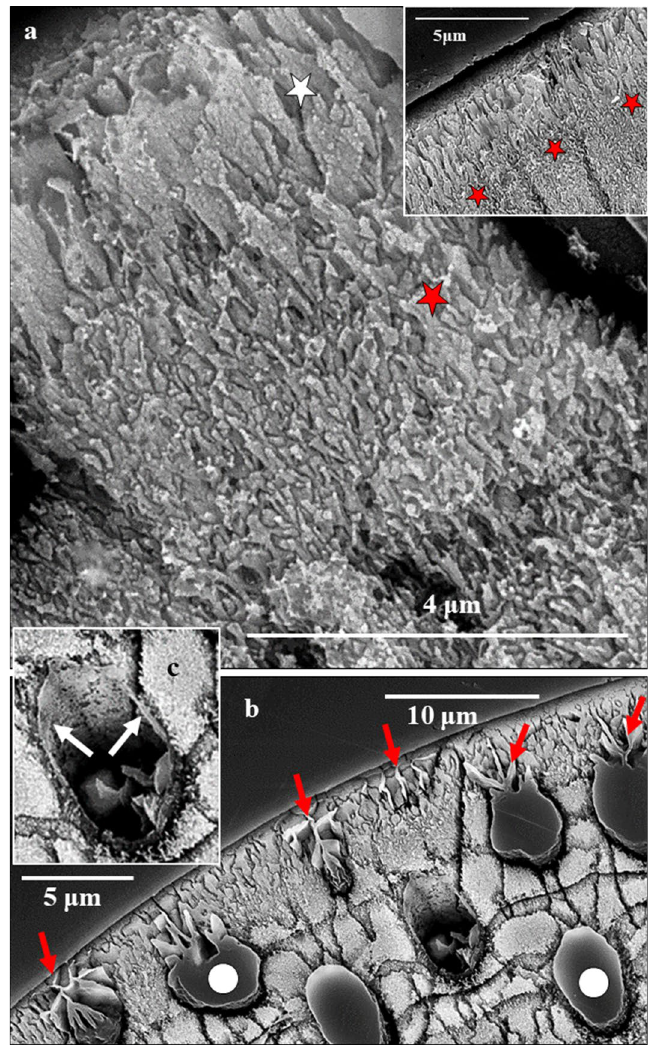
Figure 3. BSE images of cross-sections through the shell of Pulleniatina obliquiloculata visualizing the enlargement of crystal size towards outer shell surfaces. ( a ) development of irregularly shaped, platy crystals from the nanofibrils at/within the POS. Red stars in ( a ) and in insert in ( a ) indicate shell layers formed of fused elongated/sheaf-like crystals. Assemblies of large, plate/blade-shaped crystals comprise the cortex (white star in ( a )). ( b ): At outermost shell surfaces, fissures and cavities are present between the large plates/blades. At sample preparation the fissures between the plates become infiltrated with the used low-viscosity EPON resin (red arrows in ( b )). White dots in ( b ) indicate pores filled with EPON resin. White arrows in ( c ) point to the biopolymer film that lines the inner surface of a pore. See also Fig.